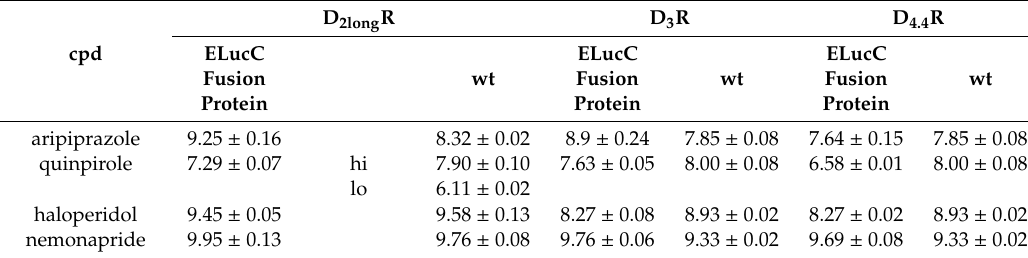
Table 2. Inhibition constants (p K i ) of selected standard ligands determined in radioligand displacement experiments. p K i values were determined at receptors fused to the C-terminal fragment of the Emerald luciferase using whole cells and at wild-type receptors using homogenates. Data represent mean p K i ± SEM determined in three independent experiments, each performed in triplicate. D 2long R D 3 R D 4.4 cpd